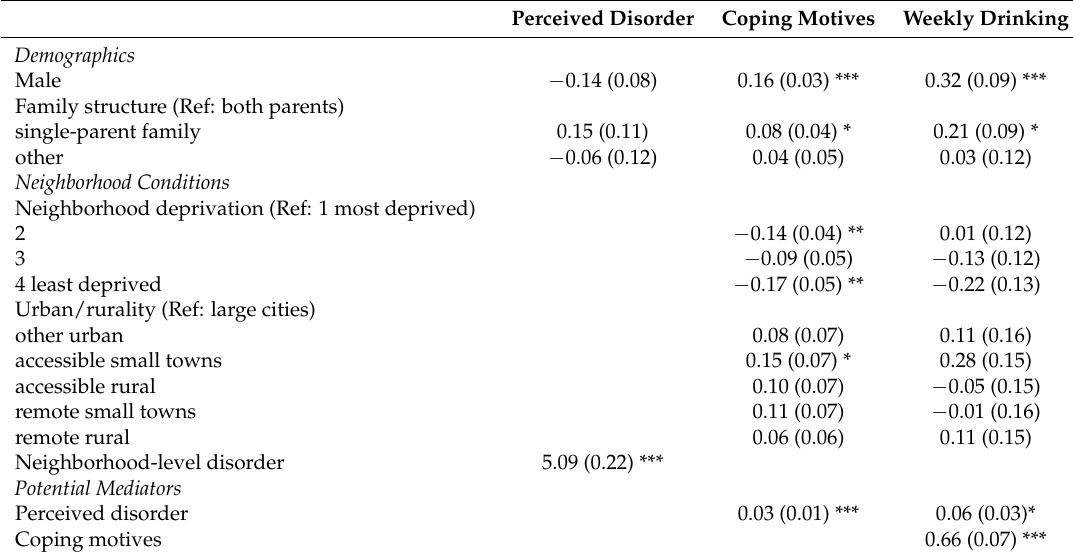
Figure 1. Hypothesized path model of neighborhood conditions on Scottish adolescent weekly alcohol consumption. Table 4. Unstandardized coefficients (standard errors) for path models.